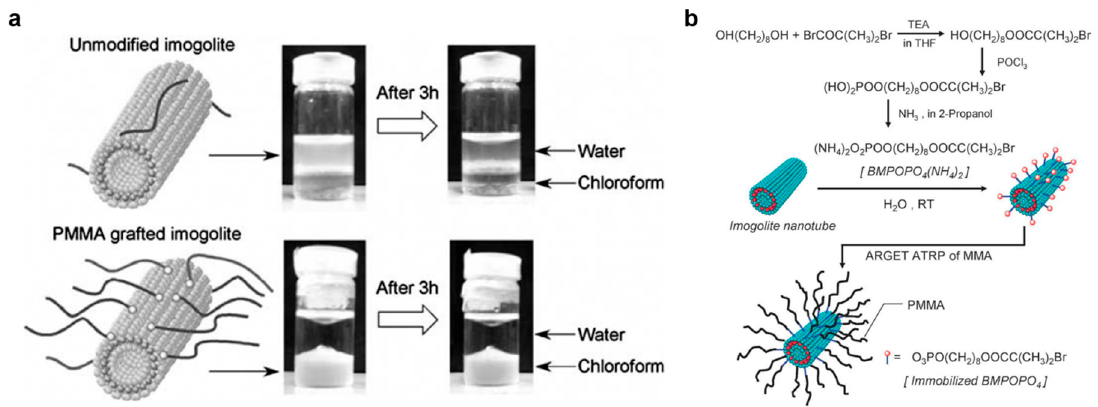
Figure 5. Illustration of outer surface modification of imogolite nanotubes. ( a ) Dispersion state of unmodified and poly(methylmethacrylate) (PMMA) grafted single-walled aluminosilicate imogolite nanotubes (Si-SWINT) in water/chloroform mixtures. ( b ) Flowchart of the modification and the immobilization of the initiator (BMPOPO 4 , see Table 2) used for surface-initiated polymerization of methyl methacrylate (MMA). Adapted with permissions from [90,92].